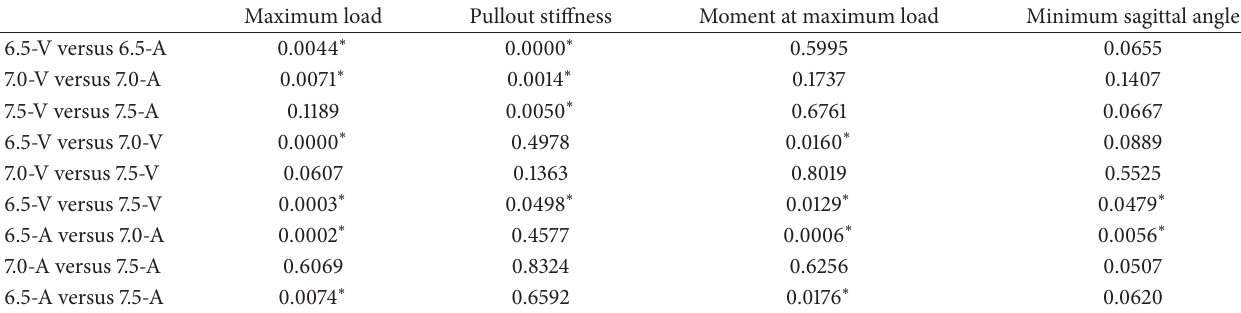
Figure 3: Flexion moment test setup and central point. Table 2: Statistical evaluation of test